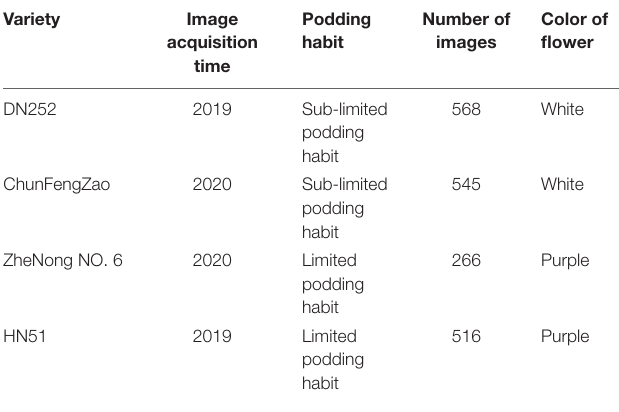
TABLE 1 | Basic information on image